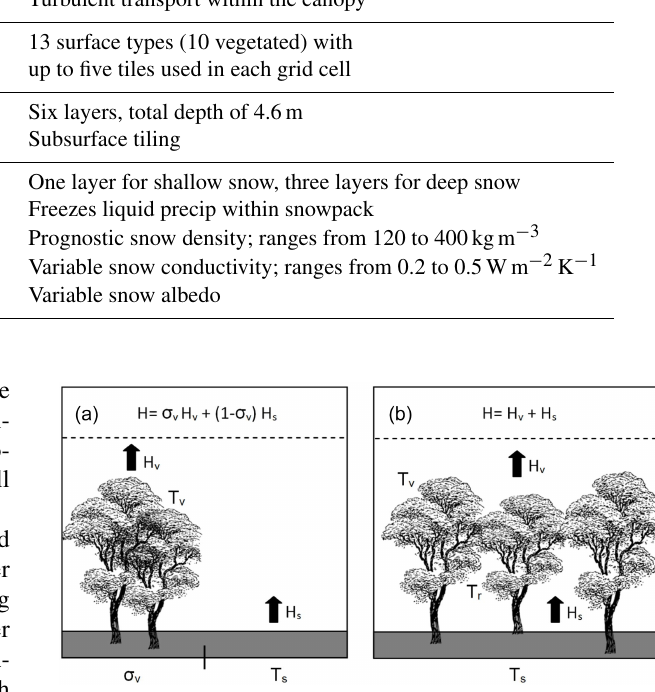
Figure 1. The representation of vegetation in (a) MOSES, where vegetation is beside bare ground, and in (b) CABLE, where vege- tation is above the ground. The mean grid heat flux, H , in MOSES is a sum of the fluxes weighted by the tile fractions, e.g. vegetation fraction, σ v . In CABLE, H is a sum of canopy, H v , and soil, H s , fluxes. The vegetation, soil, and radiative temperatures are T v , T s , and T r